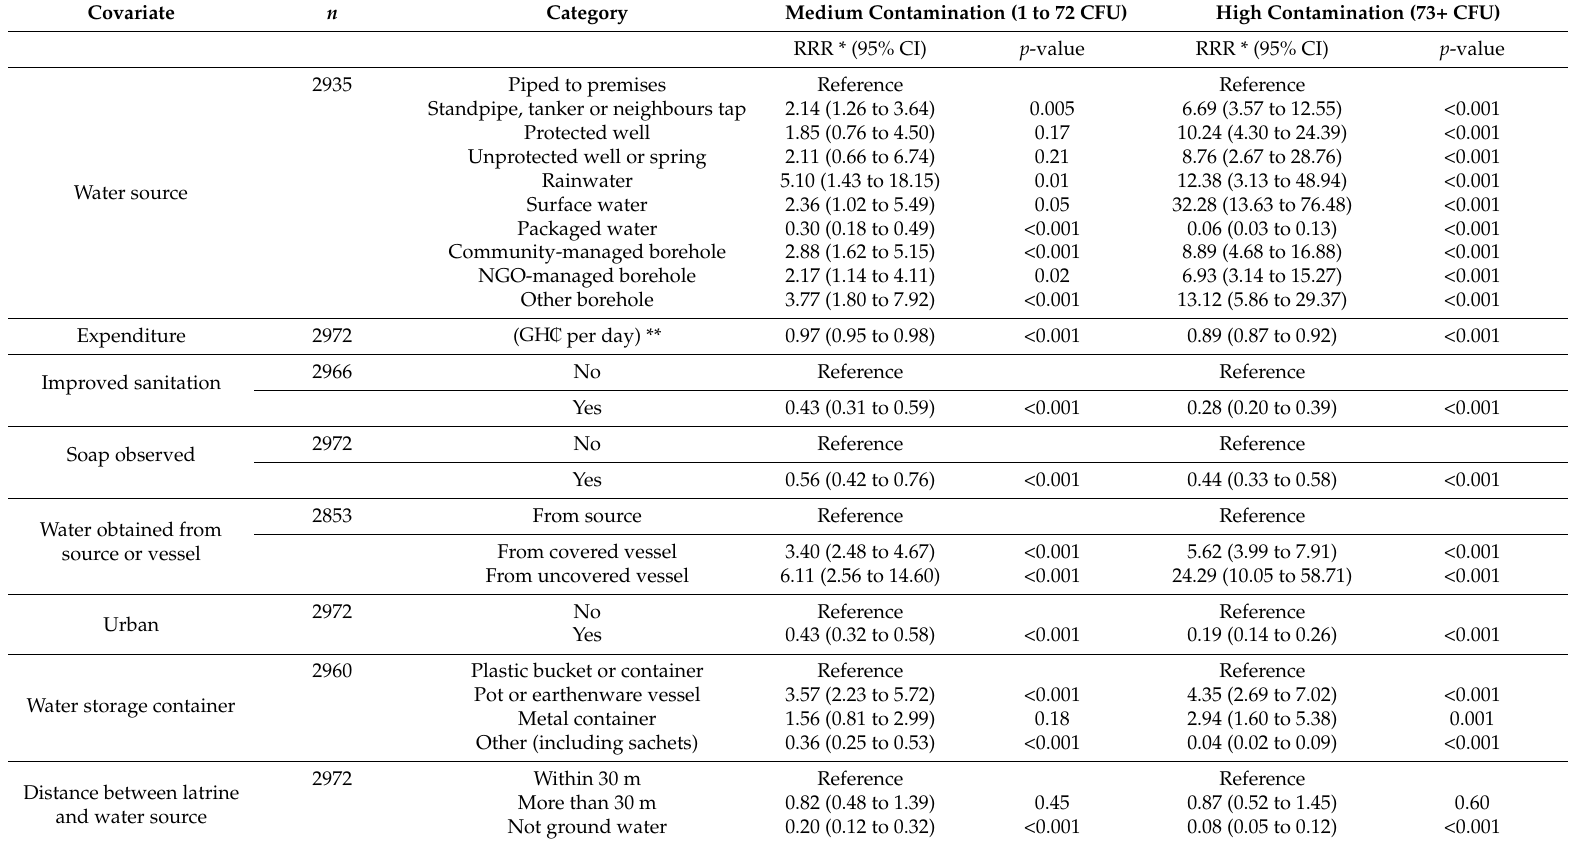
Table 2. Relative risk ratios for medium (1 to 72 cfu/100 mL) and high (>72 cfu/100 mL) contamination of water at the point of consumption with E. coli derived from univariable multinomial regression